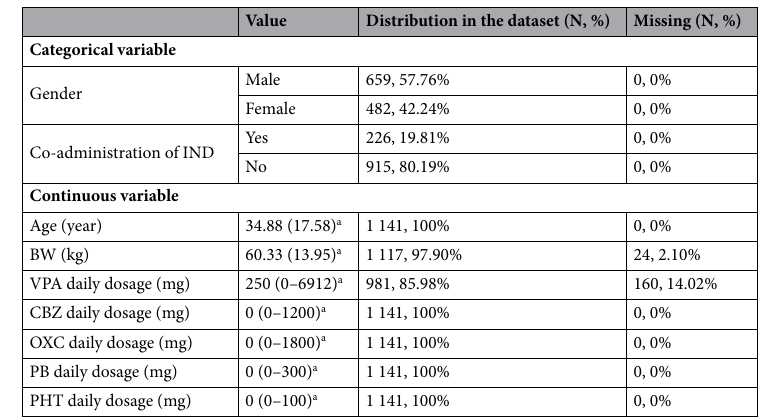
Table 2. Distribution of features in the entire dataset (N = 1141). IND enzyme inducers, BW body weight, VPA valproic acid, CBZ carbamazepine, OXC oxcarbazepine, PB phenobarbitone, PHT phenytoin. a Continuous data are reported as mean values (standard deviation) or median values (minimum ~